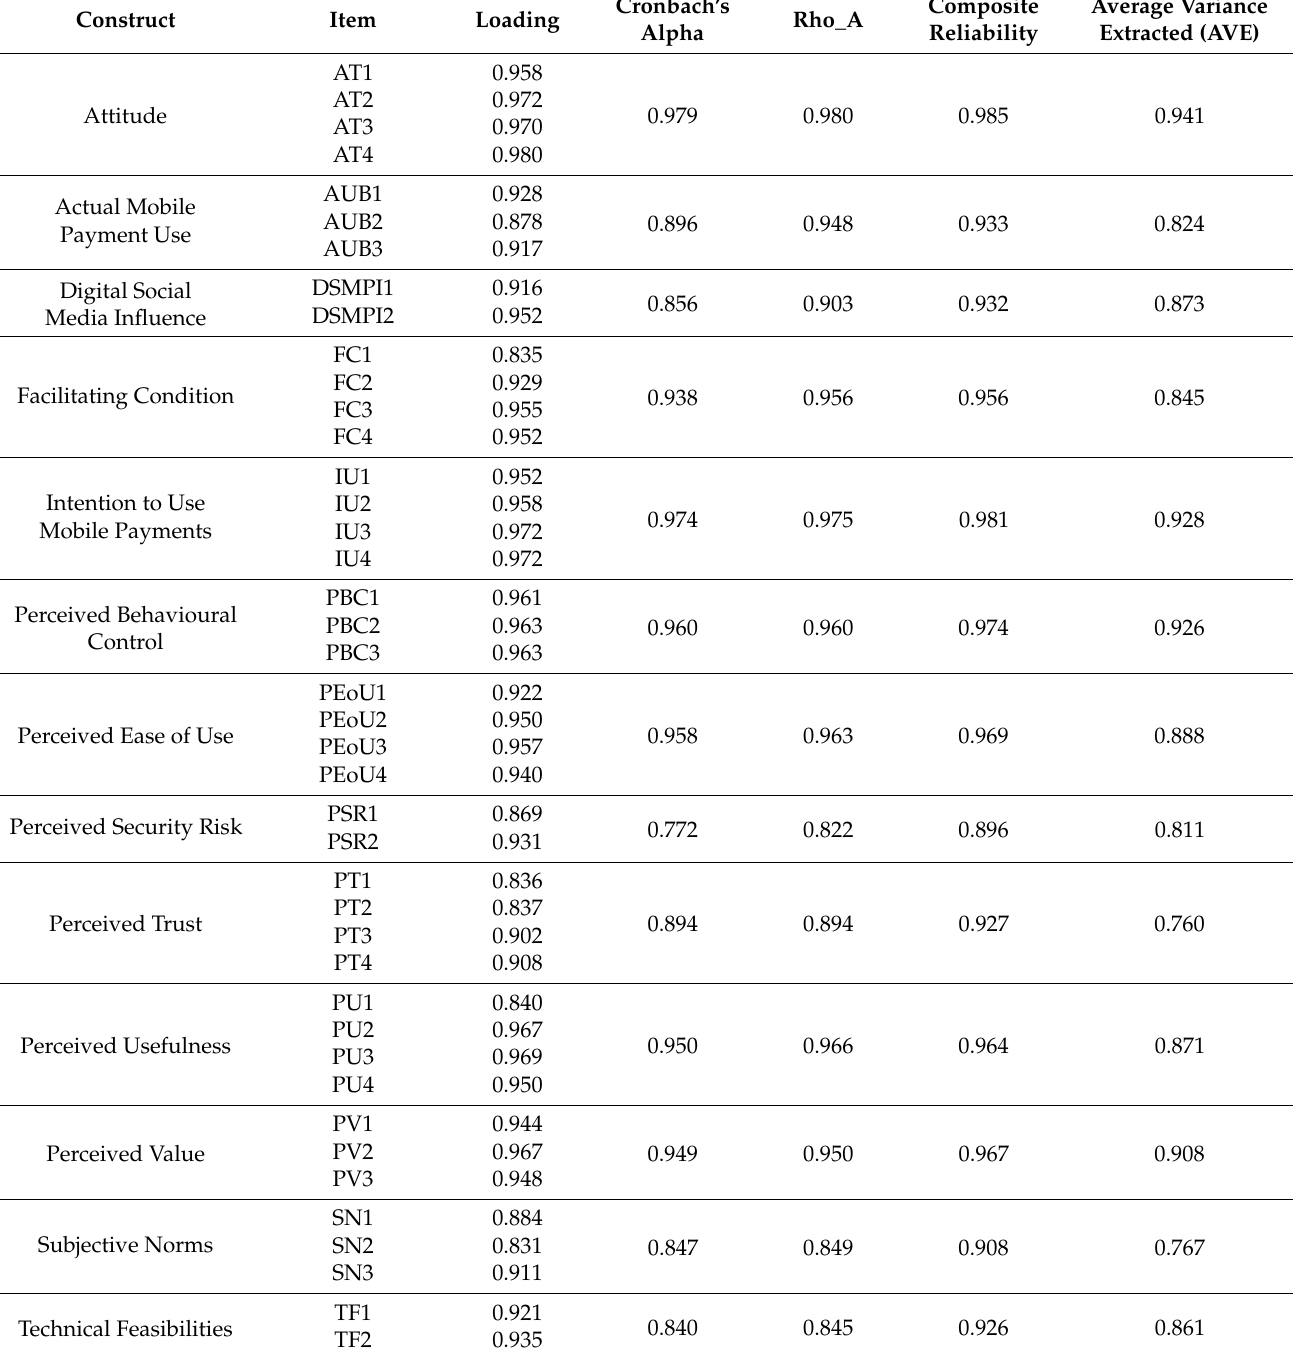
Table 2. Loading ractor, Cronbach’s alpha, roh_A, composite reliability, and